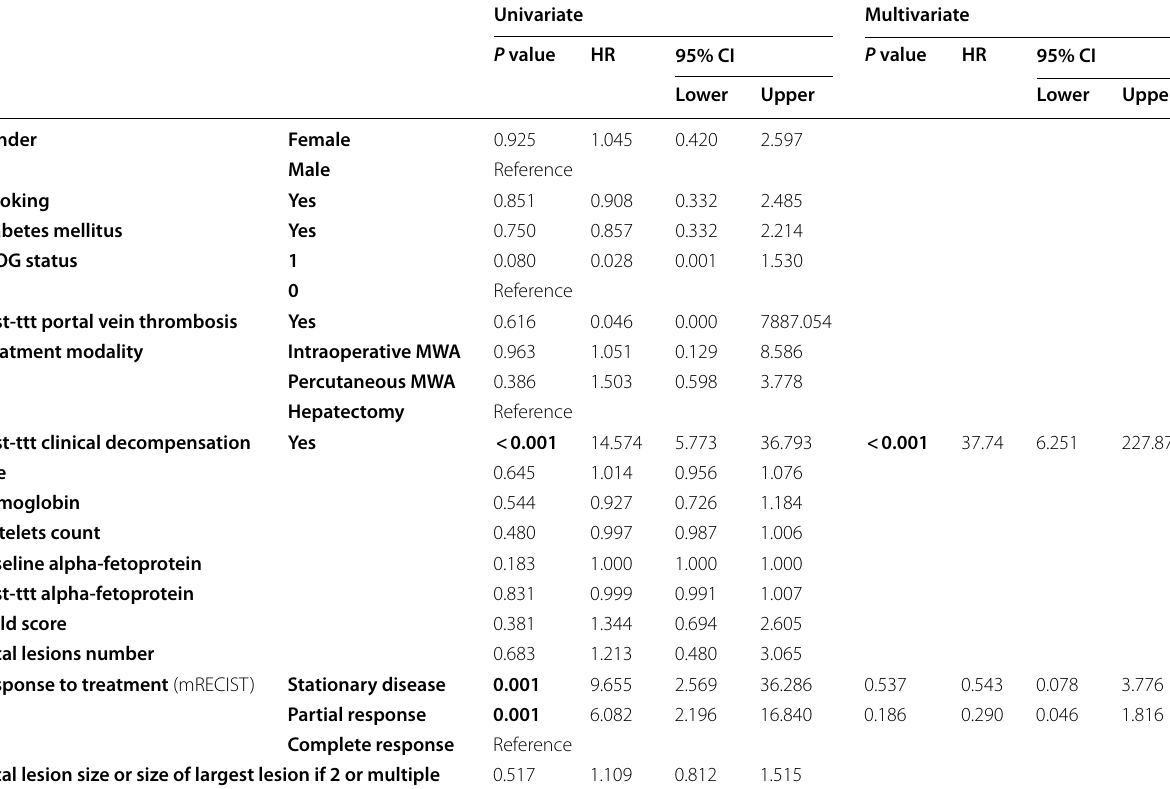
Table 4 Predictors of survival in the studied population